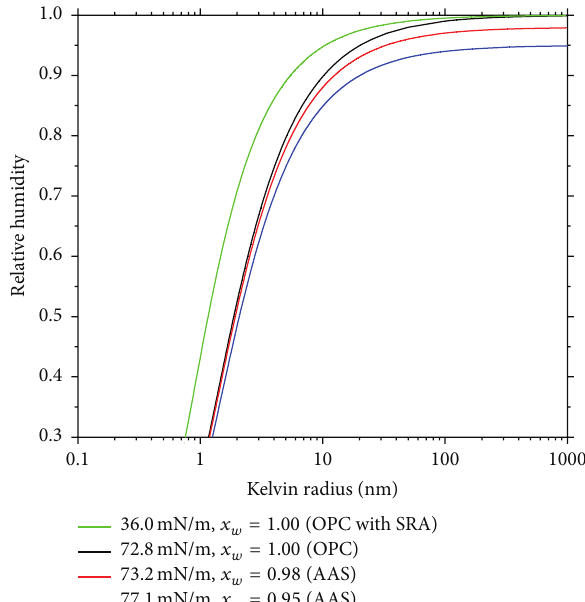
Figure 4: Correlation between Kelvin radius and RH for various cases of surface tensions and water activities. The values of liquid surface tension and water activity are postulated to represent AAS, plain OPC, and OPC with shrinkage-reducing admixture according to the research of [21,